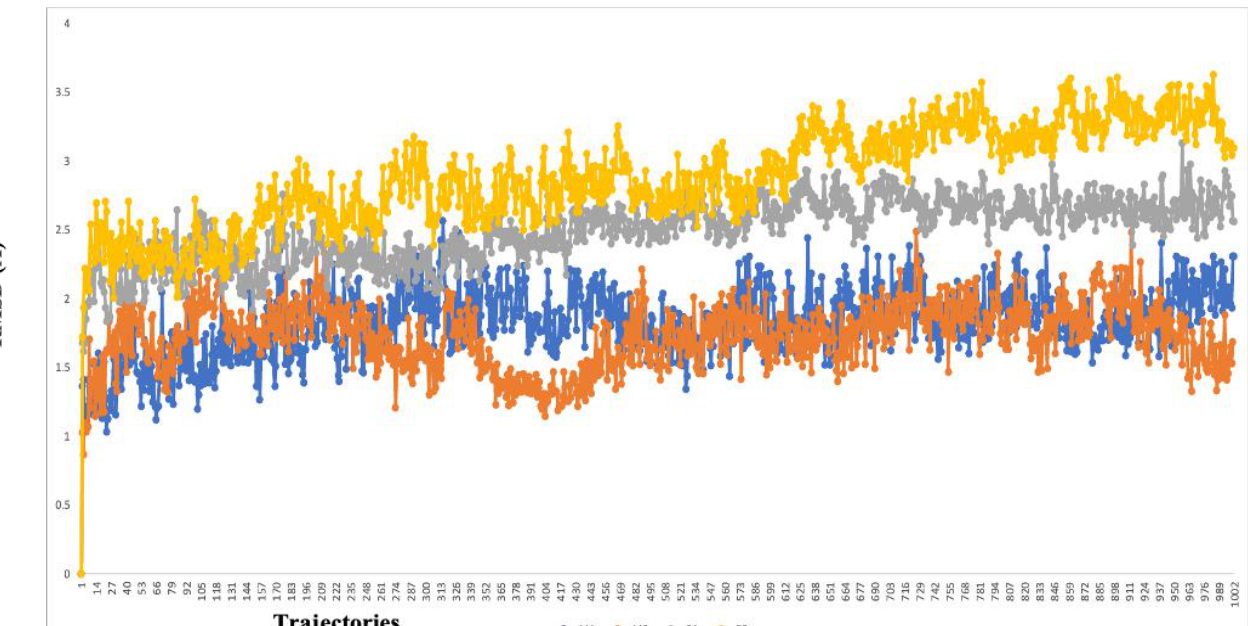
Figure 10. The RMSD graph of the two highest-ranked complex molecules of the main protease (M1—blue color, M2–orange color) and RDRP (R1—gray color, R2—yellow color). The deviation